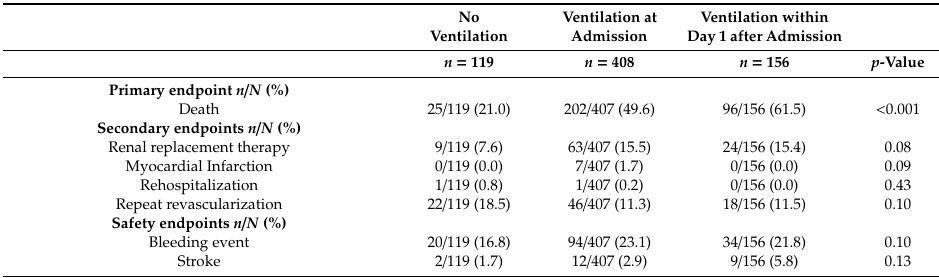
Table 3. Clinical outcomes at 30